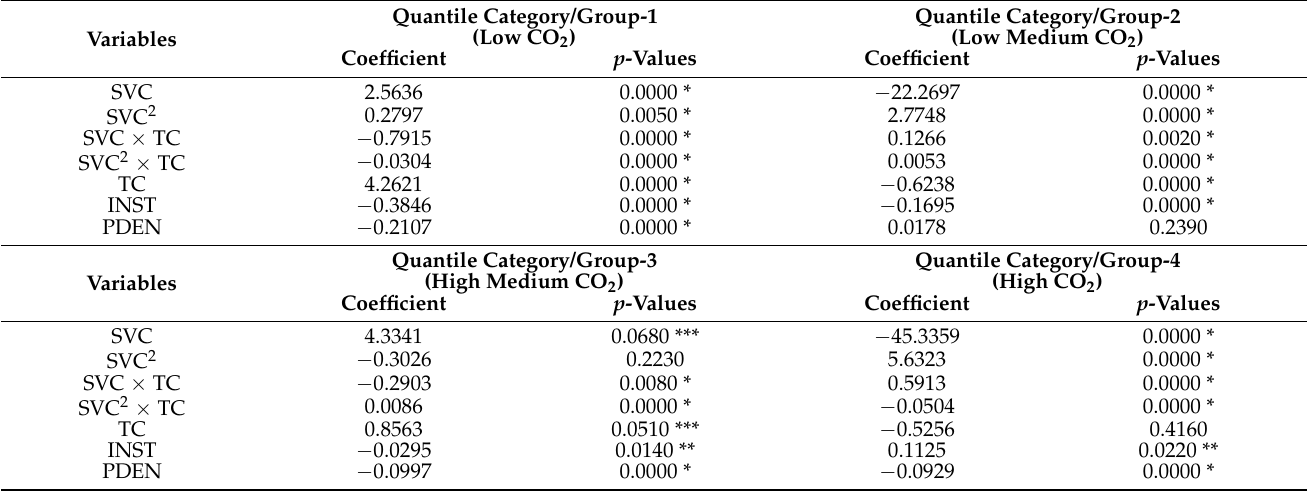
Table 5. Estimation of PQR Results for four Quantile Groups (Dependent Variable: lnCO 2